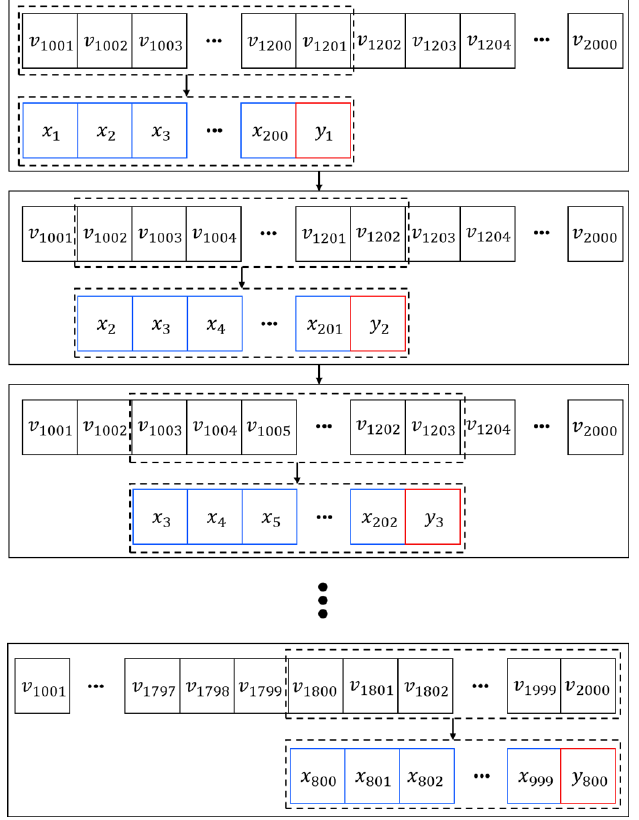
Figure 15. Process of predicting vibration values in the 40% prediction segment.